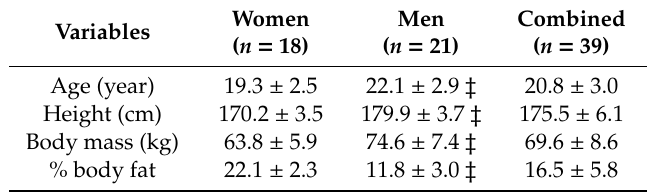
Table 1. Anthropometric characteristics of fencer athletes